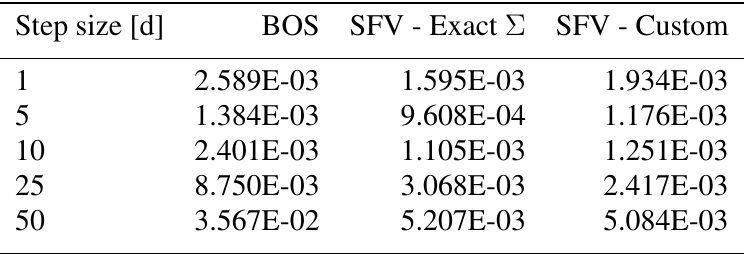
Table 1: RMS Errors for BOS and SFV